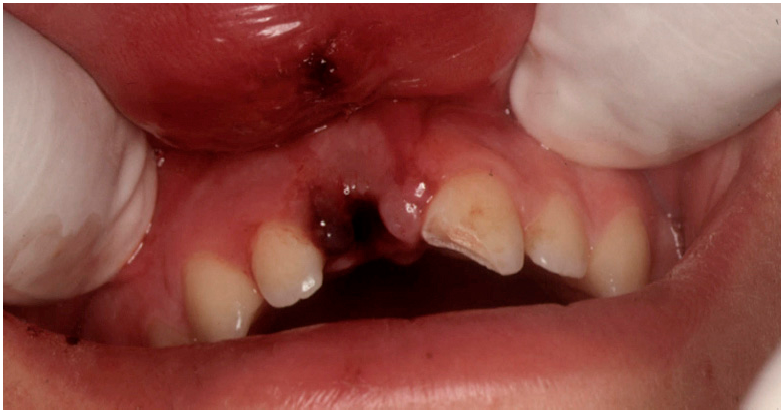
Figure 1. Intraoral view at the time of traumatic injury.